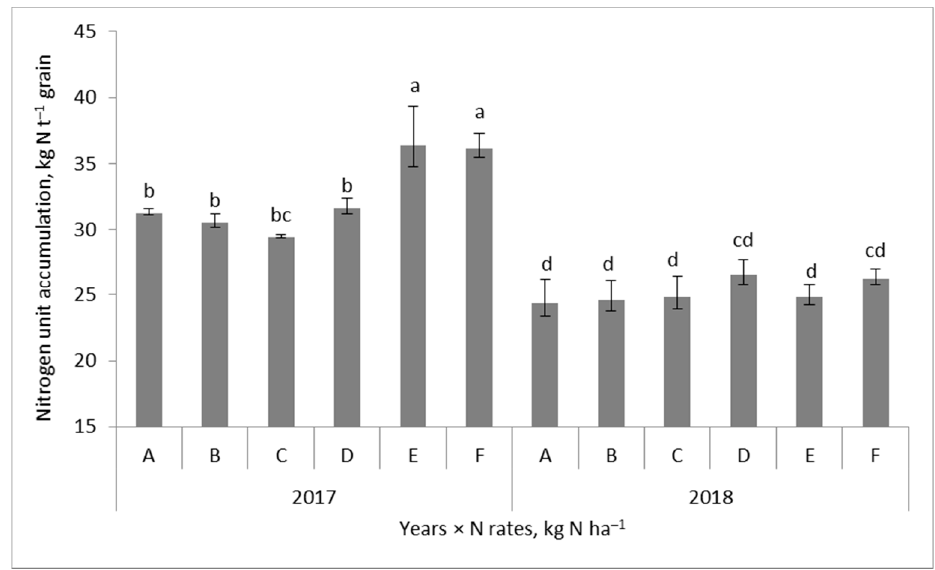
Figure A3. Effect of plant protection methods on the GREENT index of winter wheat at BBCH 75. Similar letters indicate a lack of significant differences between experimental treatments using Tukey’s test. The vertical bar in the column is the standard error of the mean.